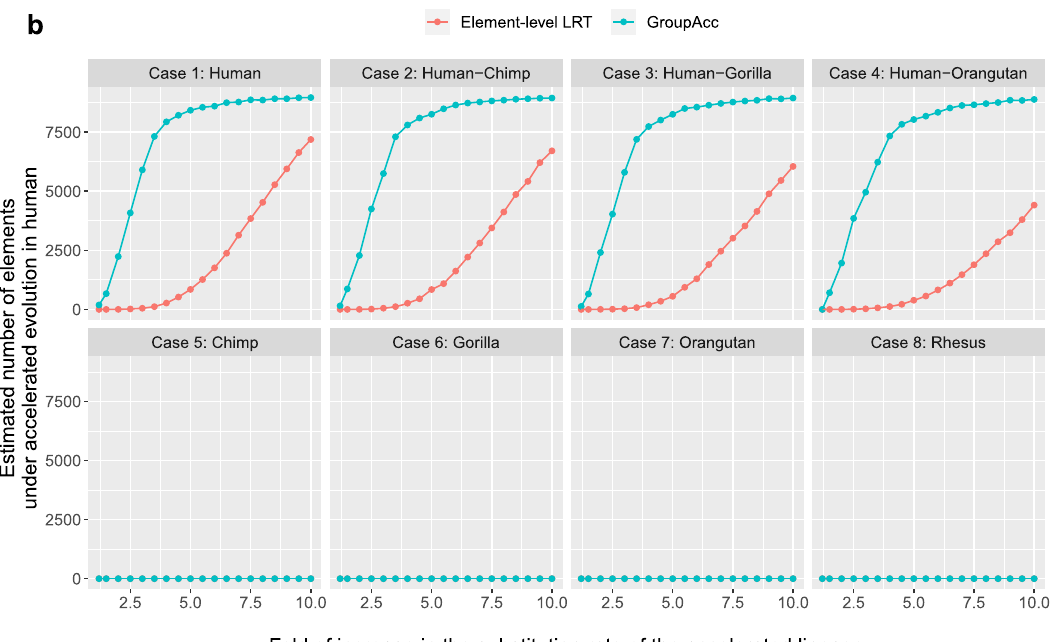
estimated from group-level LRT. b Comparison of the estimated number of ele- mentsunderacceleratedevolutioninhumanbetweenGroupAccandelement-level LRT method. Blue curves are the estimates of GroupAcc. Red curves are the esti- mates of element-level